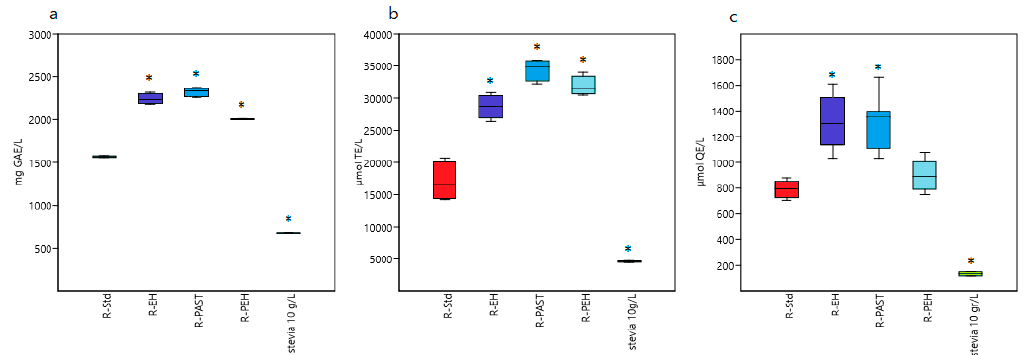
Figure 2. Antioxidant activity of the raspberry juices: ( a ) Folin–Ciocalteu; ( b ) oxygen radical absorbance capacity (ORAC); ( c ) cellular antioxidant activity (CAA). Stevia 10 g/L: stevia crude water extract. * p <0.0001 vs R-Std group. The data are represented as box plots, showing median, 25–75% quartiles, and total range of values of duplicates from two batches ( n ≥ 6). R-Std, blank juice without stevia addition, values are corrected with water 10% v / v . R-EH, juice supplemented with 10% v / v of stevia crude water extract immediately before heat treatment. R-PAST, juice supplemented with 10% v / v of stevia crude water extract immediately before pasteurization. R-PEH (juice supplemented with 1% w / v of stevia dried leaf powder immediately before heat treatment) values are corrected with water 9% v / v .